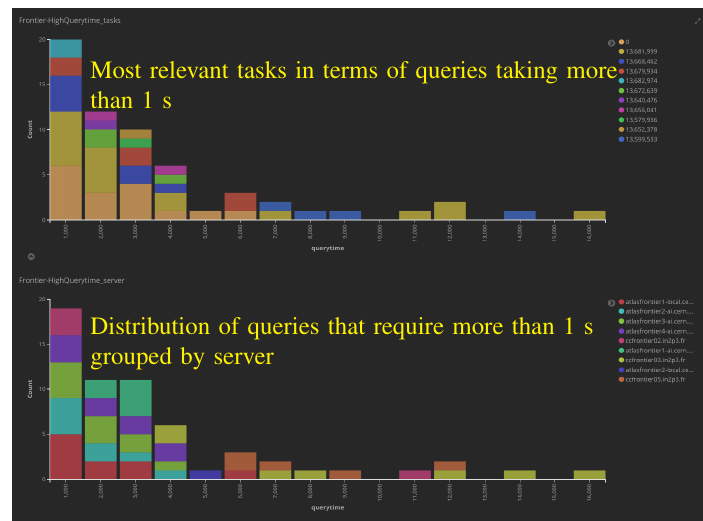
Figure 3. Kibana Dashboard: distribution of time-demanding queries grouped by task ID’s (top) and Fontier servers